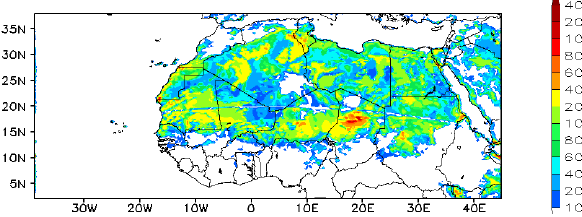
Fig. 11. Annual mean of the aerosol dust emission (in gm − 2 ) over West Africa, simulated by ALADIN-SURFEX between 2006 and